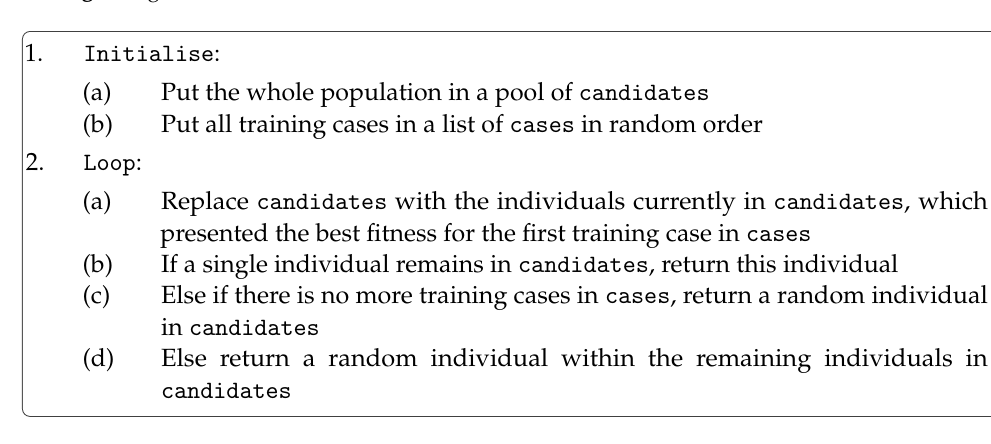
Table 1. Main selection methods available in DEAP and PonyGE2. Method DEAP PonyGE2 Tournament